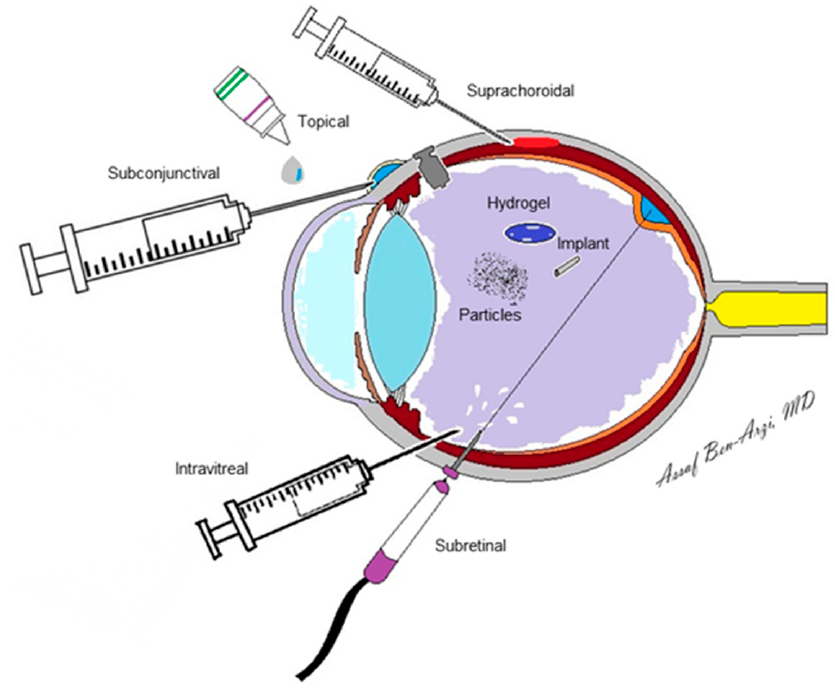
Figure 2. The various pathways of drug delivery to the posterior segment.